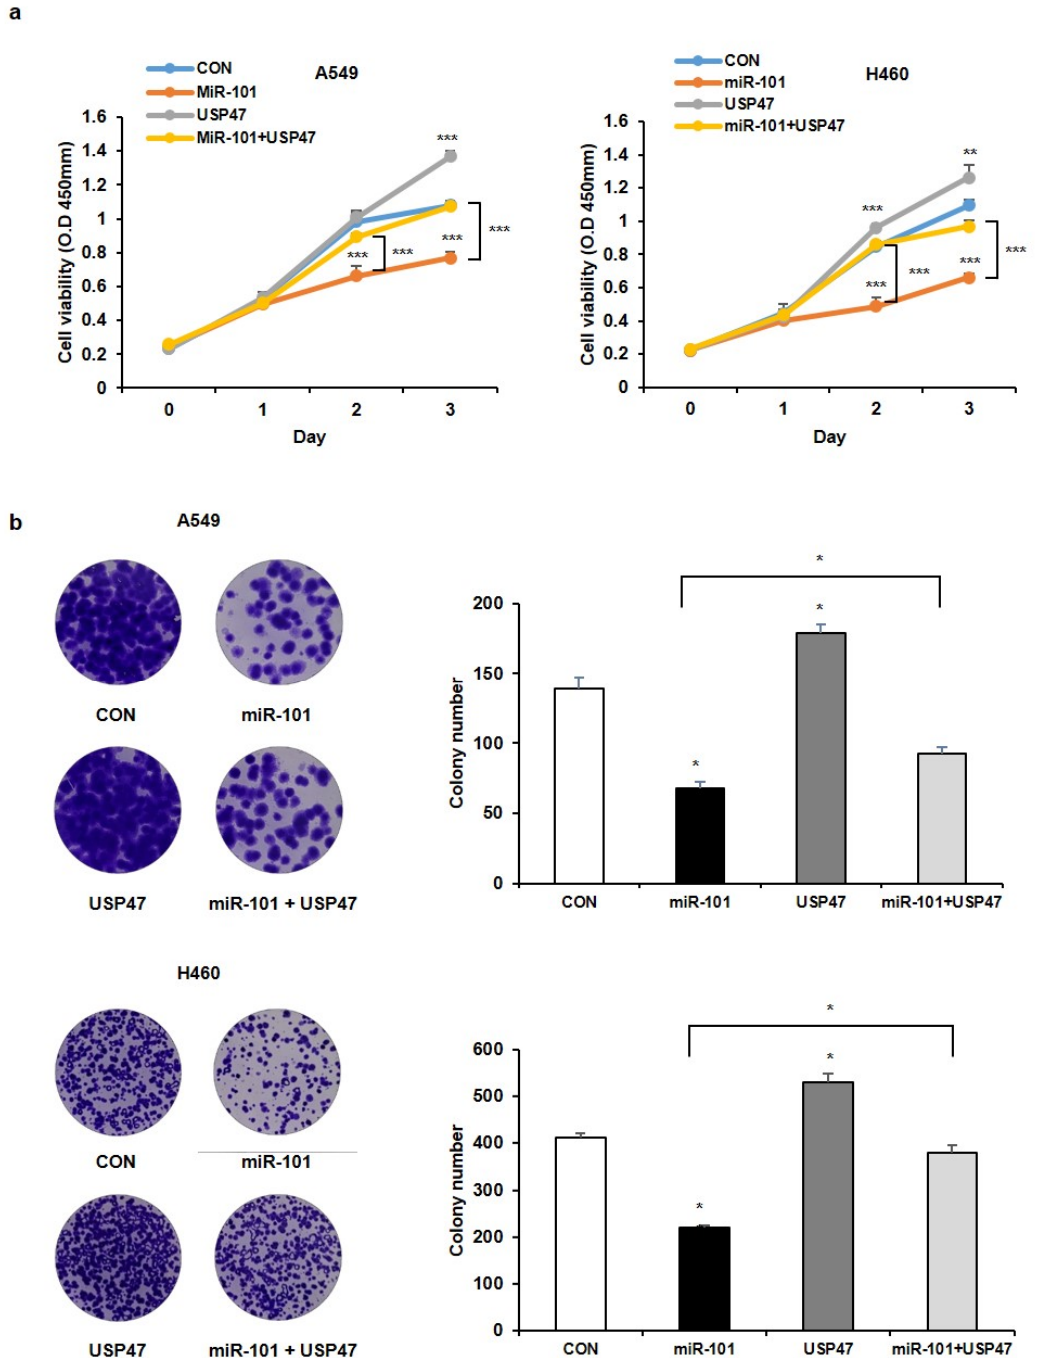
Figure 3. MiR-101-3p inhibits cancer cell growth by targeting USP47. ( a , b ) A549 and H460 cells were transfected with a miR-101-3p mimic or Flag-USP47 alone, or together. ( a ) Cell viability was measured at the time indicated by the WST-1 assay. ( b ) 15 days after transfection, the cells were stained with crystal violet in a 6-well plate. The number of colonies for each group was normalized to the control (CON). The data in all parts represent the mean ± SD (* p < 0.05, ** p < 0.005, *** p < 0.0005, t -test).